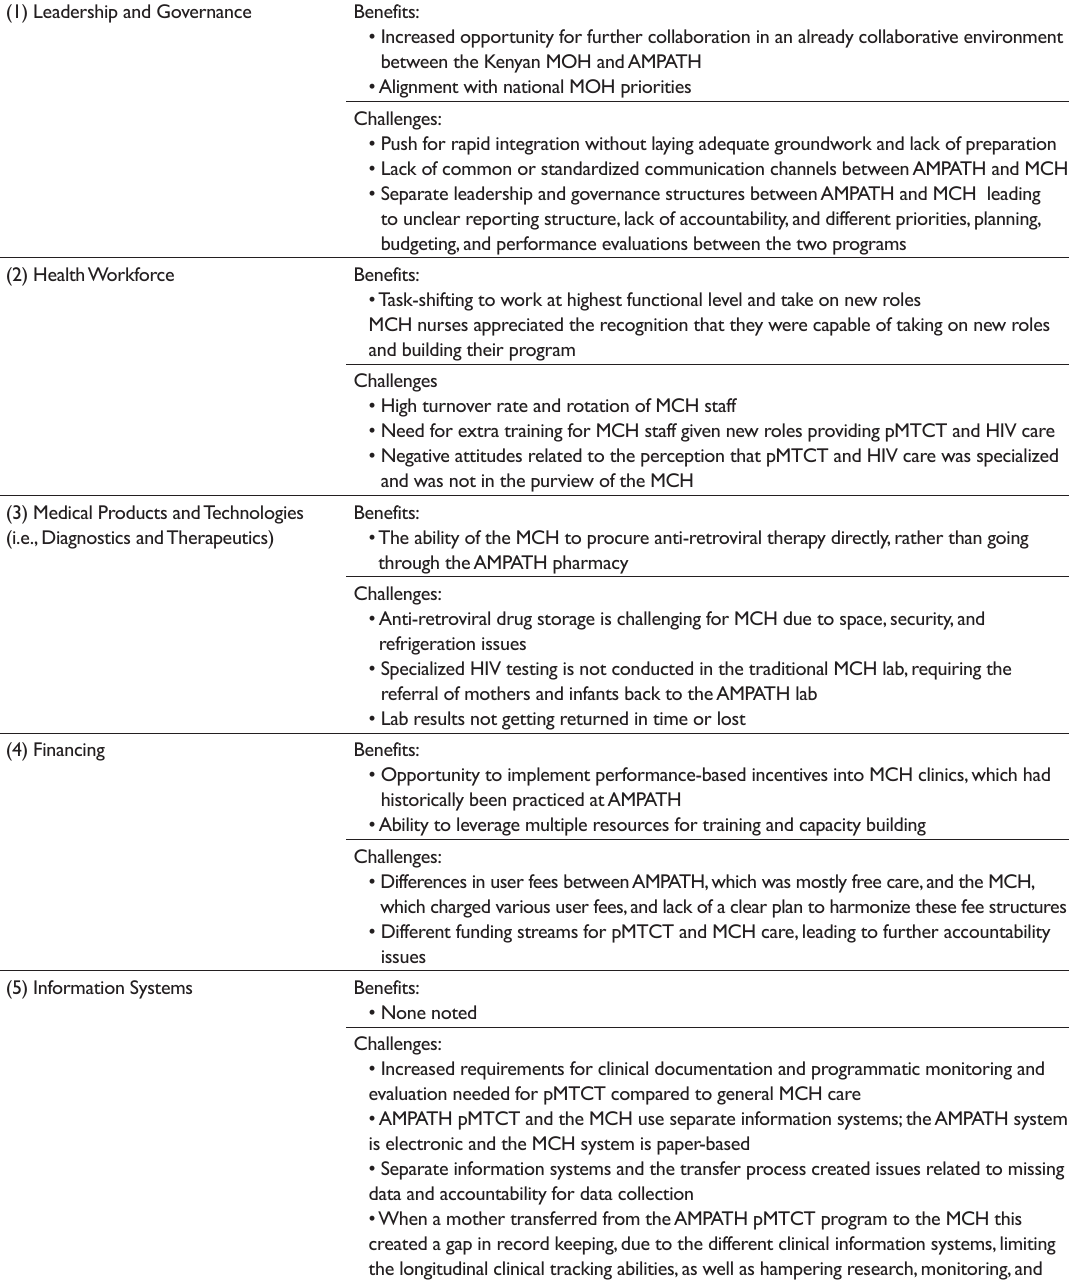
Table 1: Benefits and challenges of pMTCT – MCH integration organized by the WHO’s six critical health systems